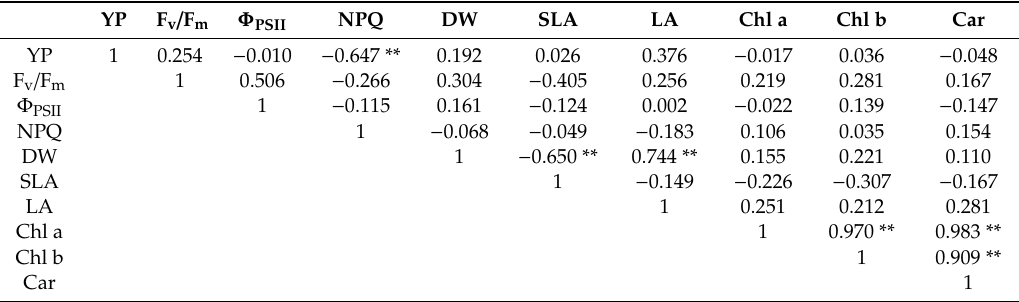
compared to the control genotype. Conversely, E76 and E107 genotypes showed the highest NPQ values compared to the control and the other genotypes. The correlations among the analyzed physiological and structural parameters are reported in Table 2.